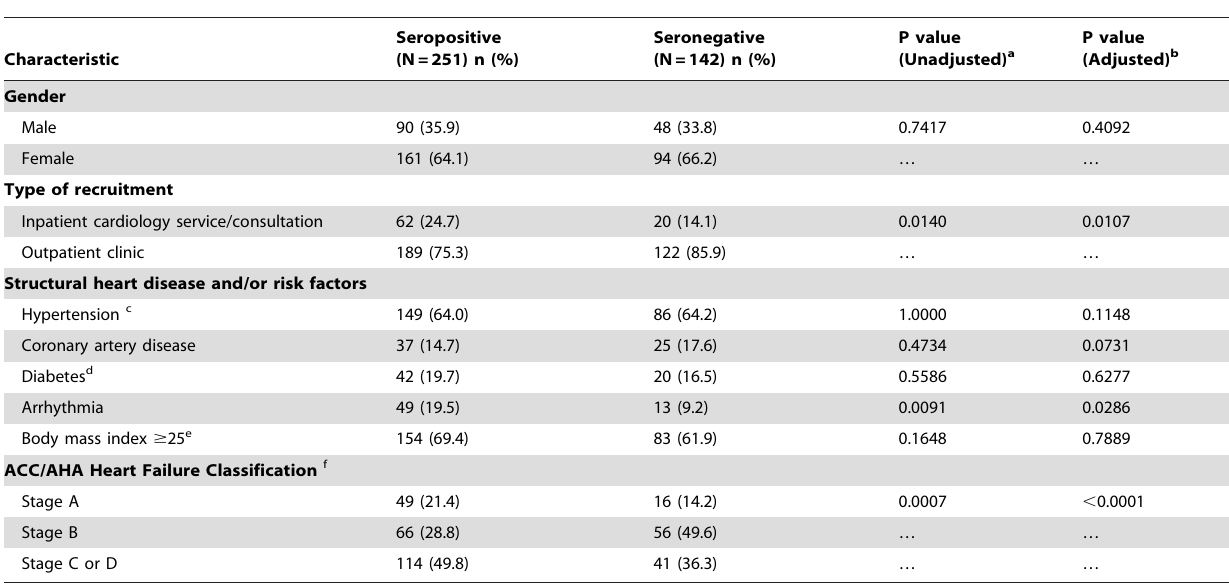
Table 1. Characteristics of seropositive and seronegative study participants.